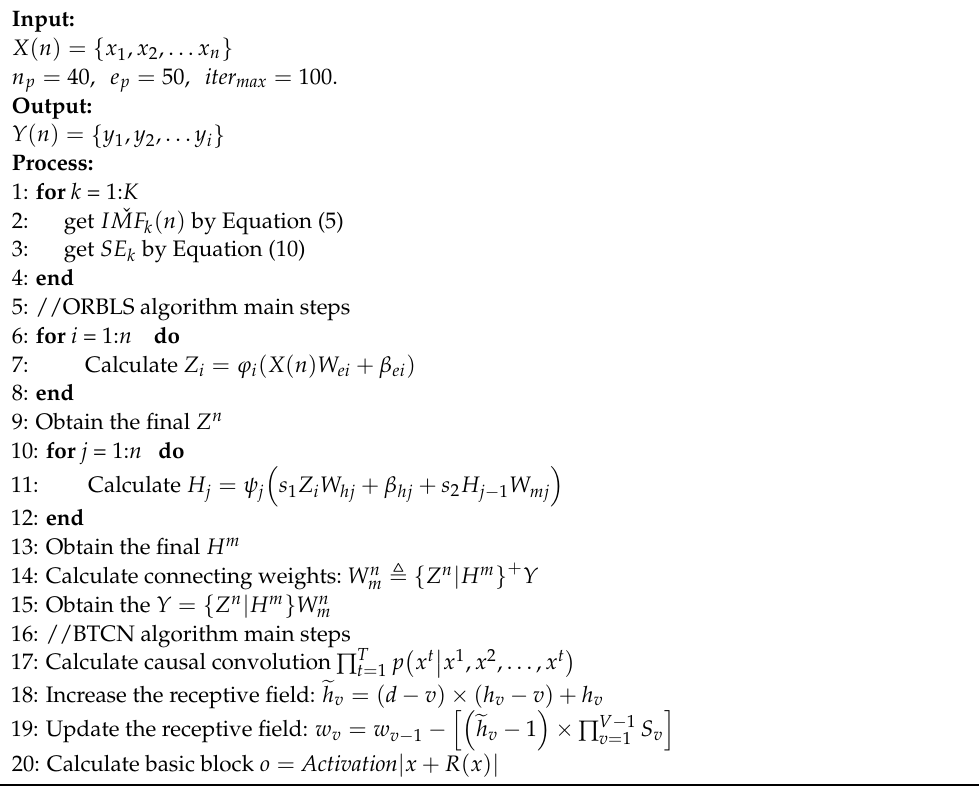
Algorithm 1: The proposed predictive framework for